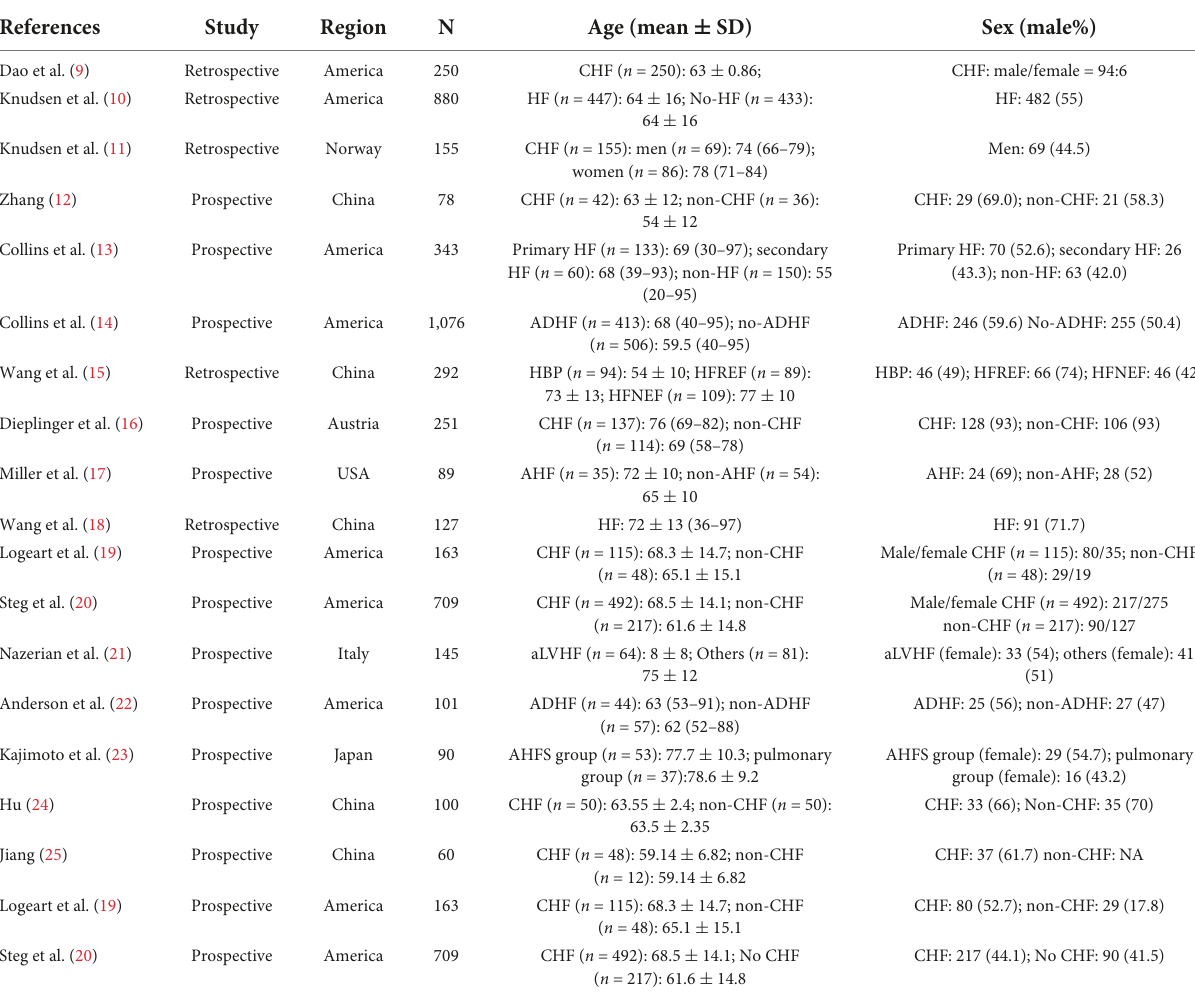
TABLE 1 Basic characteristics of enrolled